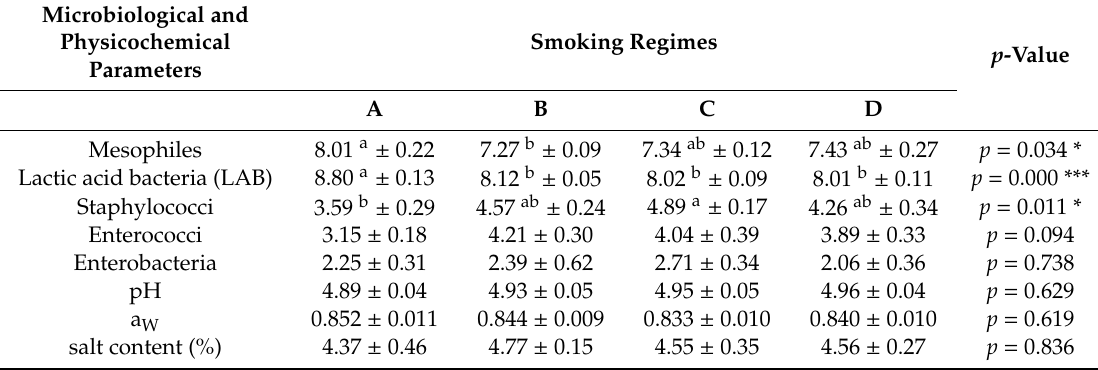
Table 1. E ff ect of smoking on microbiological and physiochemical parameters of dry-cured sausages. Microbiological